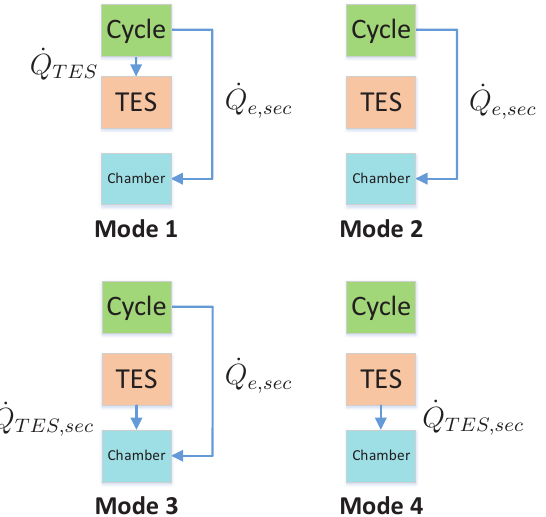
Figure 5. Most useful operating modes of the TES-backed-up refrigeration